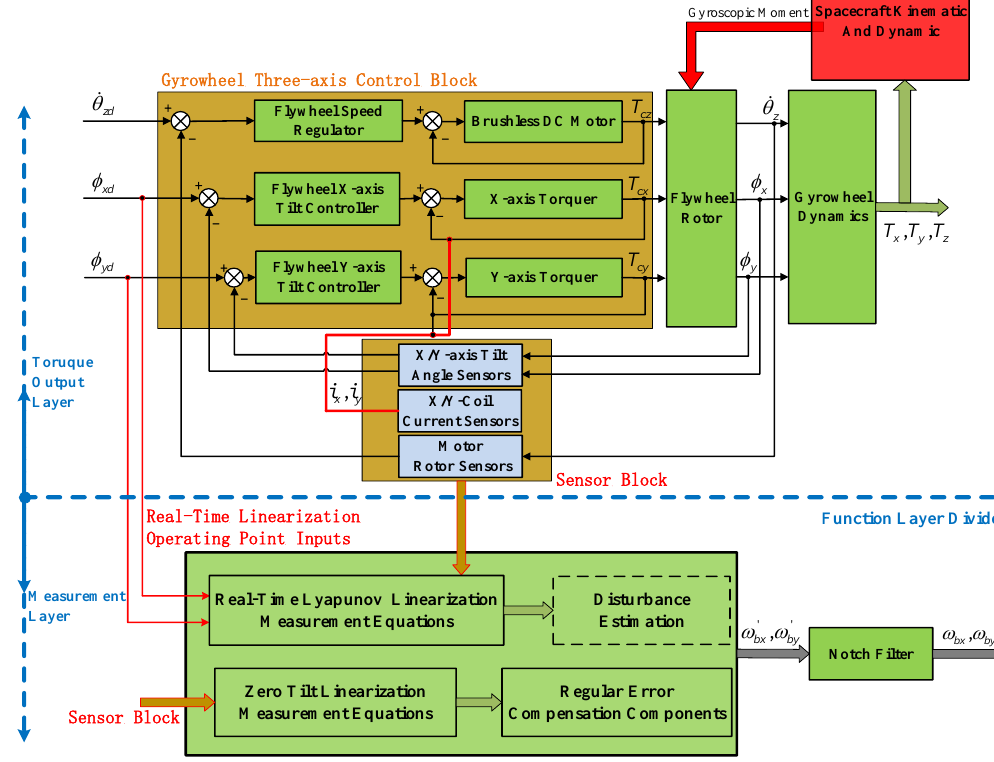
Figure 4. Simulation platform of spacecraft angular rate sensing based on the gyrowheel